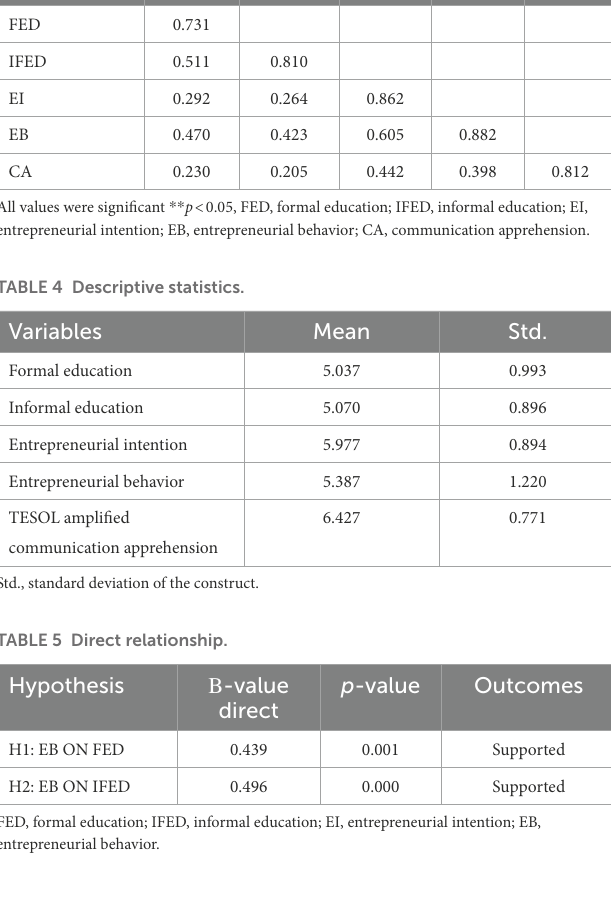
TABLE 3 Correlation and discriminant validity. Variables